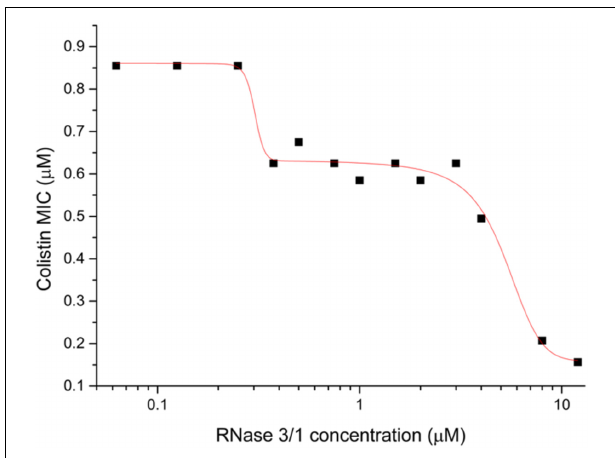
FIGURE 3 | Biphasic dose-response fit of the variation of the MIC 100 of colistin against A. baumannii as a function of the RNase 3/1 concentration. The non-linear fitting was done using OriginLab 8